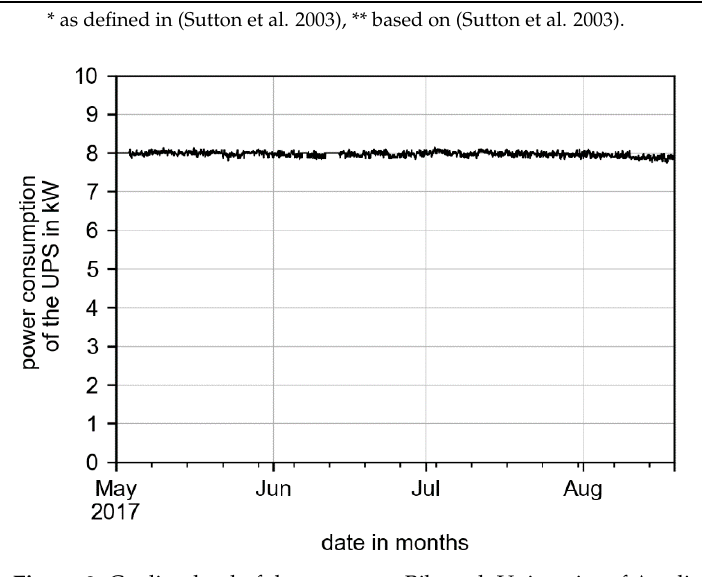
Figure 9. Cooling load of the servers at Biberach University of Applied Sciences.